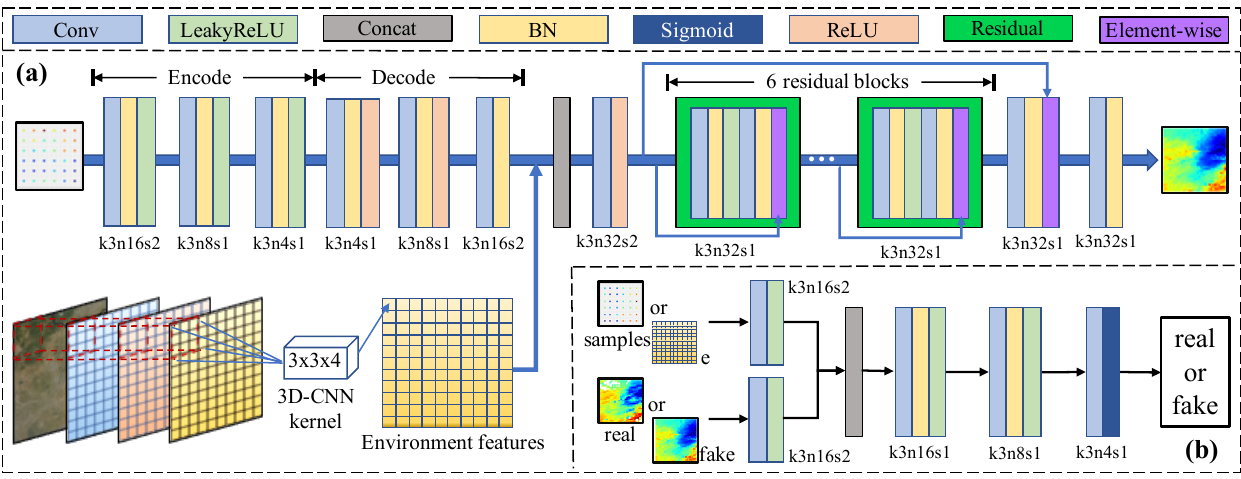
Figure 2. The network architecture of the proposed model with the corresponding kernel size (k), number of feature maps (n), and stride (s) indicated for each convolutional layer. ( a , b ) are the network architecture of the generator and discriminator,